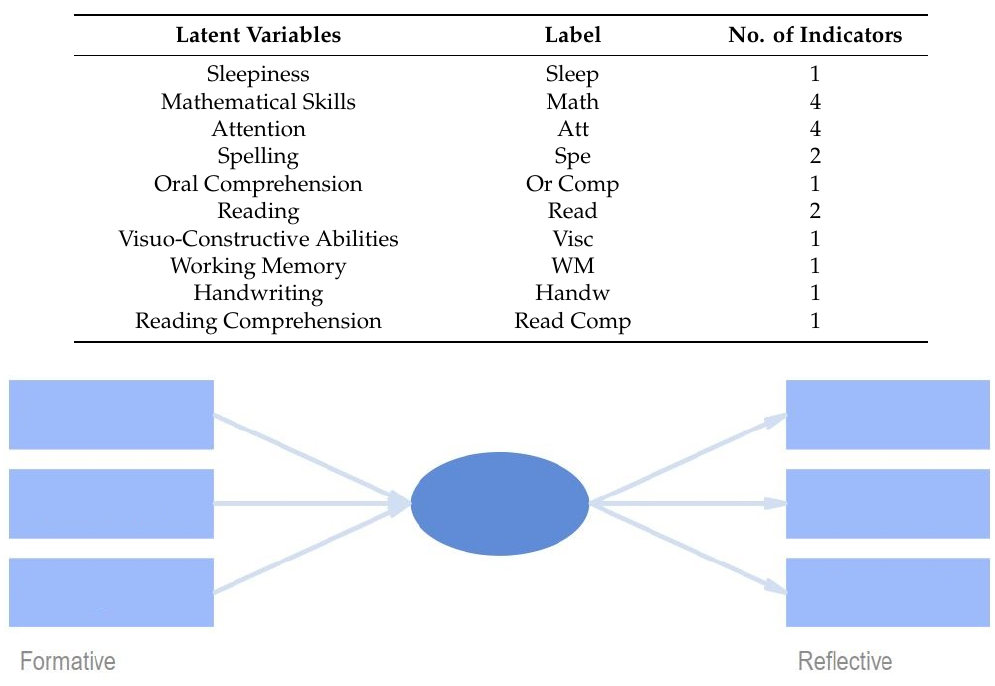
Table 1. Latent variables and indicators of the model.